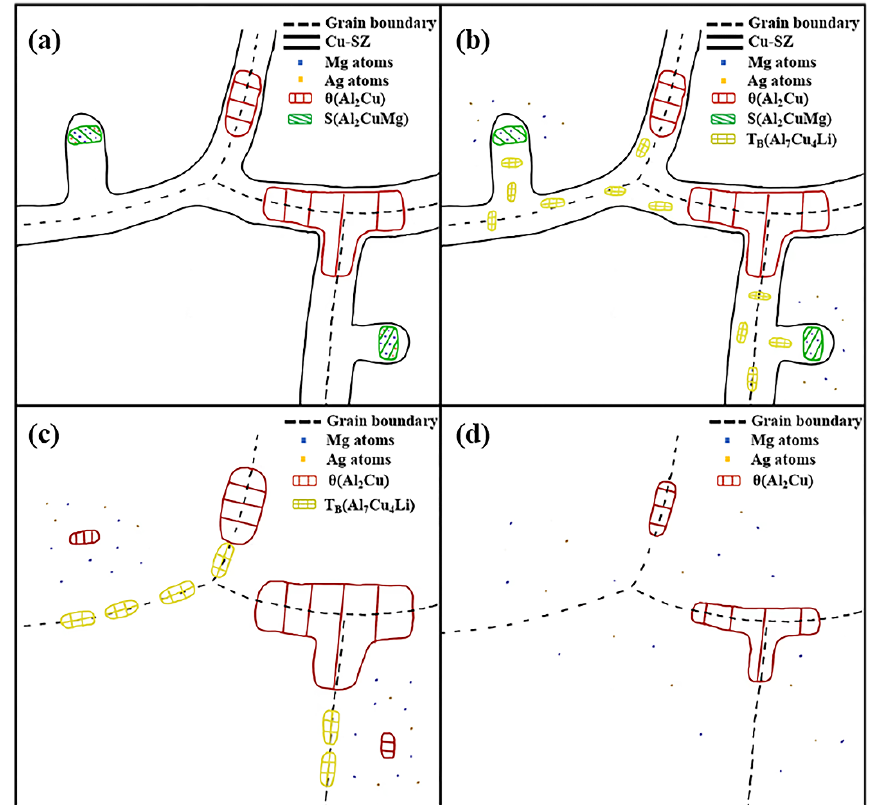
Figure 15. Schematic diagram of microstructural evolution during homogenization ( a ) 25–300 ◦ C; ( b ) 400 ◦ C; ( c ) 450 ◦ C; ( d ) 500 ◦